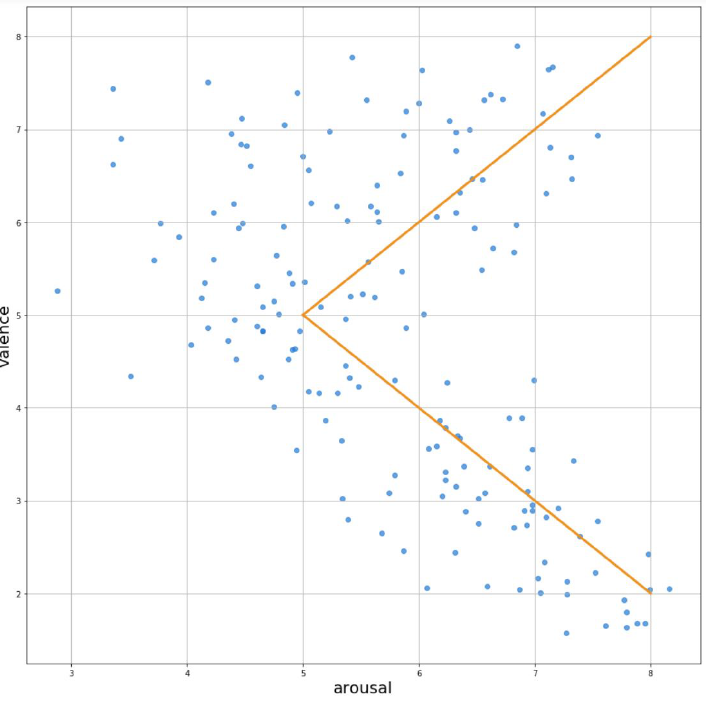
Figure 1. Trends in the IADS set stimuli